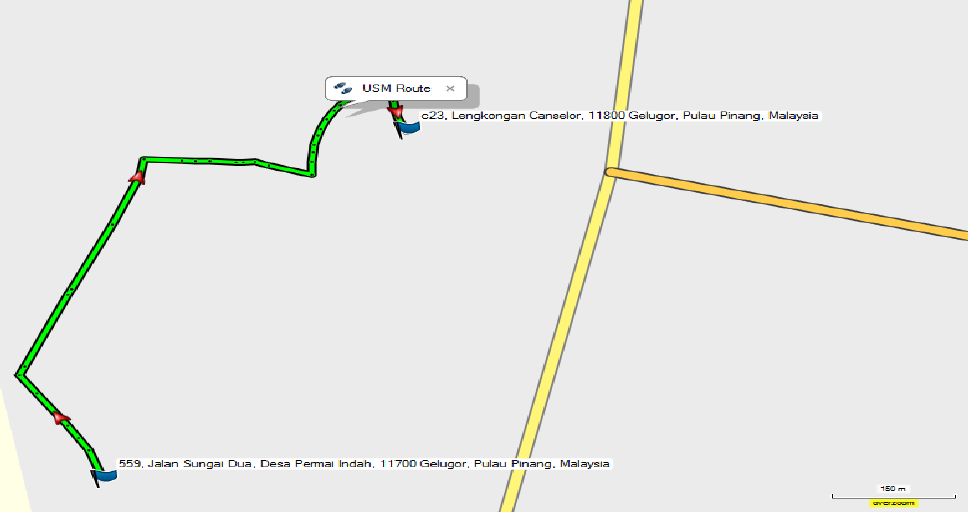
Figure 12. USM Route from Garmin